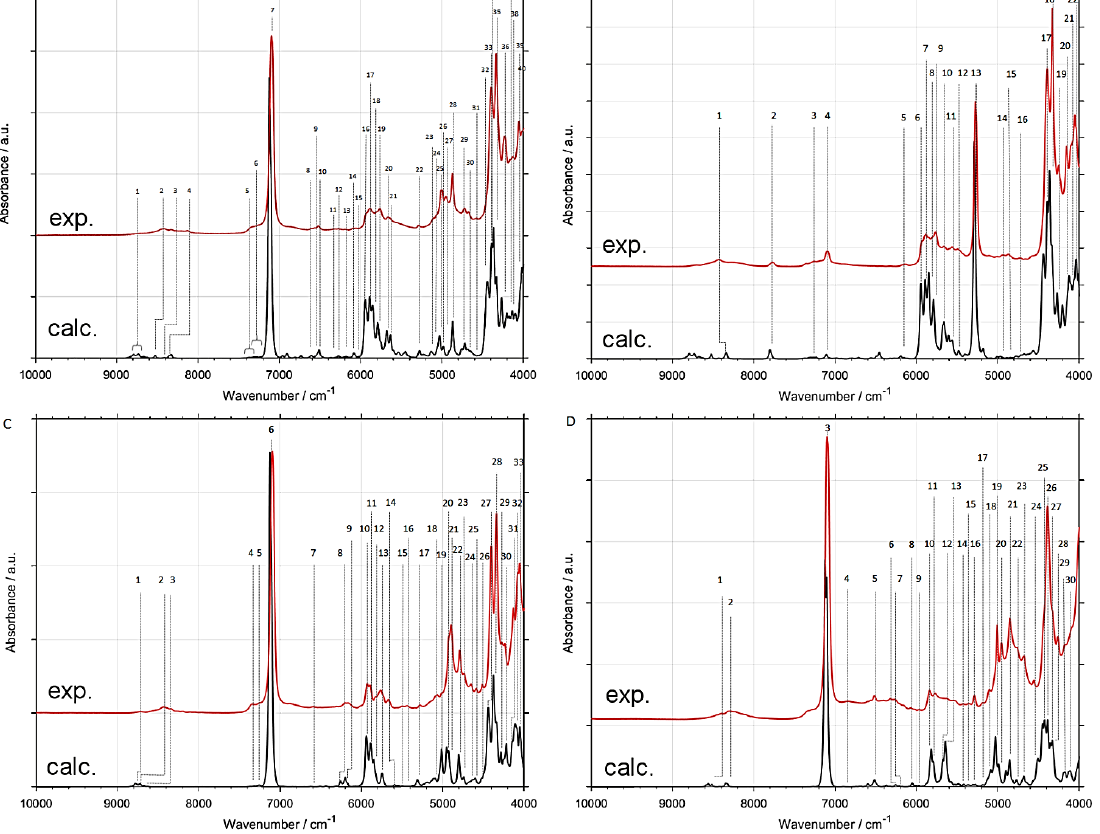
Figure 5. Band assignments in NIR spectra of deuterated ethanols based on GVPT2//B2PLYP-GD3BJ/def2-TZVP//CPCM calculations. ( A ) CH 3 CH 2 OH; ( B ) CH 3 CH 2 OD; ( C ) CH 3 CD 2 OH; ( D ) CD 3 CH 2 OH. Band numbering corresponds to that presented in Tables 2–5.